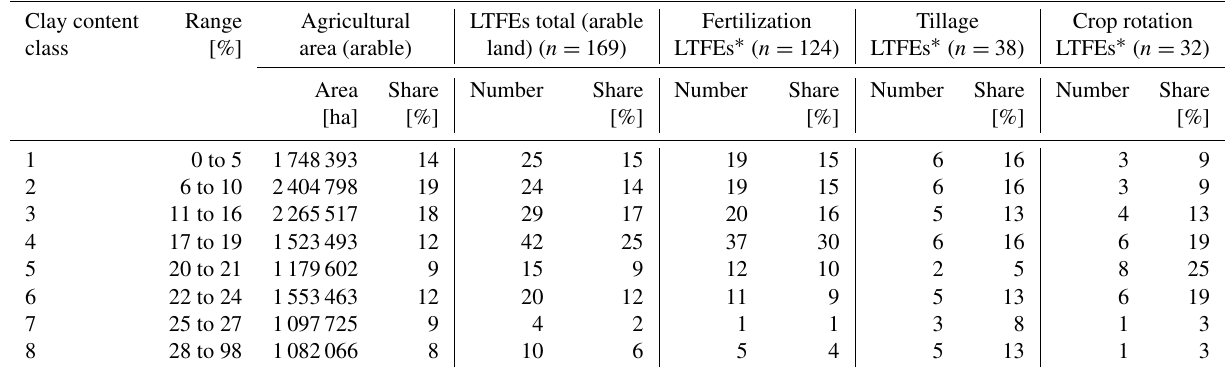
Table 5. Clay content classification according to ESDAC (2020) of arable land in Germany and the number and share of the different LTFE types in each clay content class. Clay content